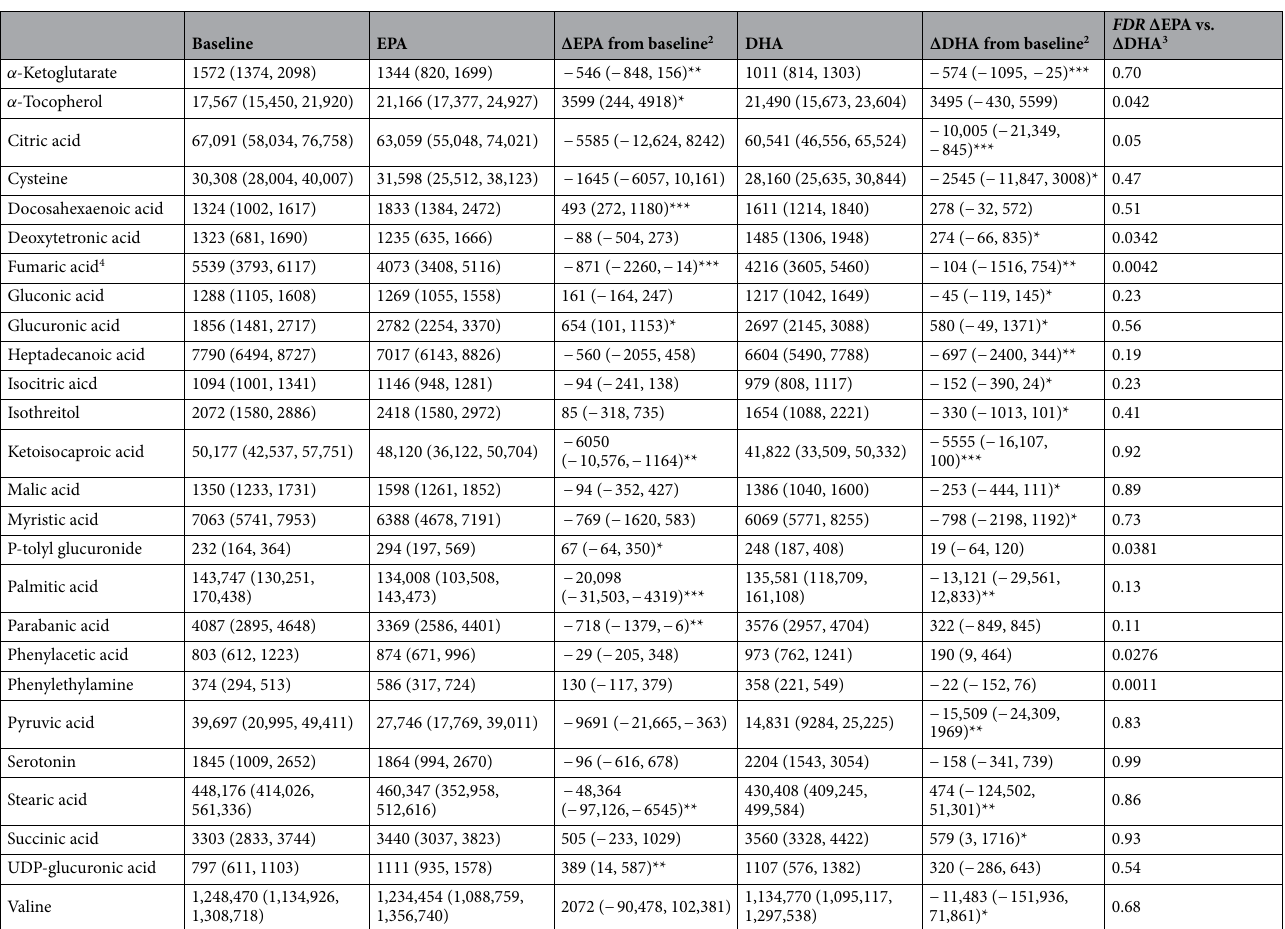
Table 3. Peak height values of serum primary metabolites at baseline and after EPA and DHA supplementation (alphabetic order) 1 . 1 Values are unadjusted and reported as median (25th, 75th). To correct for skewed distribution, generalized log-transformation and auto-scaling were applied before analysis. 2 Comparison of changes from baseline to EPA or DHA was assessed using a liner mixed-effects model. FDR- adjusted P value: * < 0.05, ** < 0.01, *** < 0.001. 3 Pairwise comparison between EPA and DHA (changes form baseline) were conducted using the lsmeansLT function from the lmerTest package for the linear mixed effect model. 4 Fumaric acid showed significant sequence effect ( p = 0.0073). When there was a sequence effect, data from the first period is extracted to run ANCOVA analysis, with baseline value and age as covariates. EPA supplementation reduced level of fumaric acid ( p = 0.0107) when sequence effect was taken into